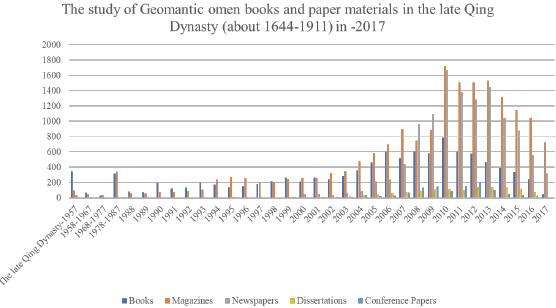
Table 2. Visualized data analysis of geomantic omen